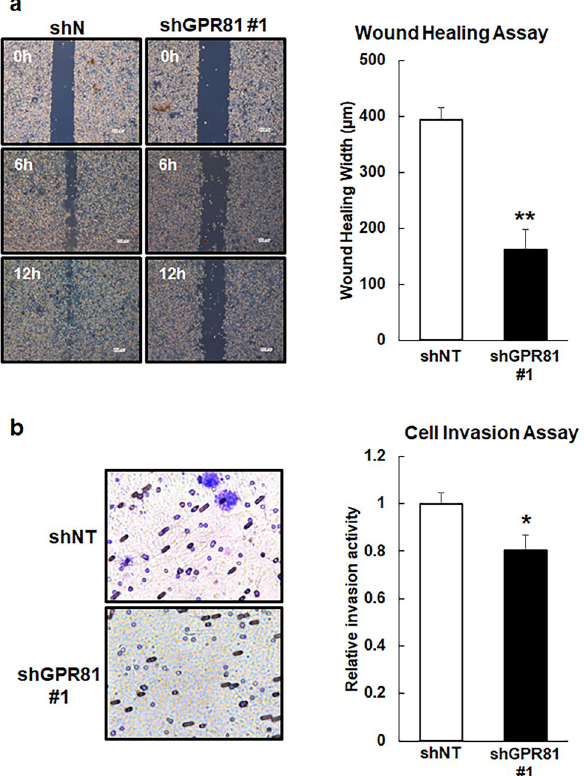
Figure 7. Impaired cell motility and invasion in shGPR81 cells. ( a ) Wound-healing assay for shNT and shGPR81 #1 cells. Monolayers of shNT and shGPR81 #1 cells were scratched, and the distances between the edges of the scratches were measured 12 h after scratching. The data are expressed as the wound healing width that contained migrating cells ( n = 3/group). ** p < 0.01 (vs. shNT); Student’s t- test. ( b ) The invasiveness of the cells was evaluated using a Boyden chamber assay. The shNT and shGPR81 #1 cells were seeded into the upper chamber of the apparatus and allowed to grow in serum-free medium. The invading cells were stained with 0.5% crystal violet and counted in 5 random squares using a light microscope ( n = 3/group). * p < 0.05 (vs. shNT); Student’s t- test.